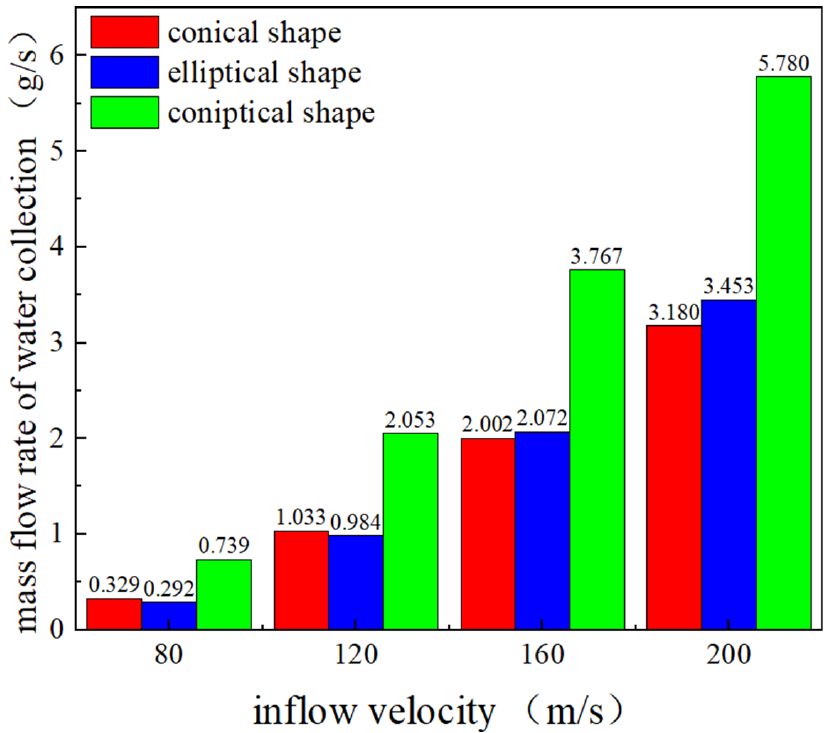
Figure 14. Comparison of water collection on three spinners with different inflow velocity.